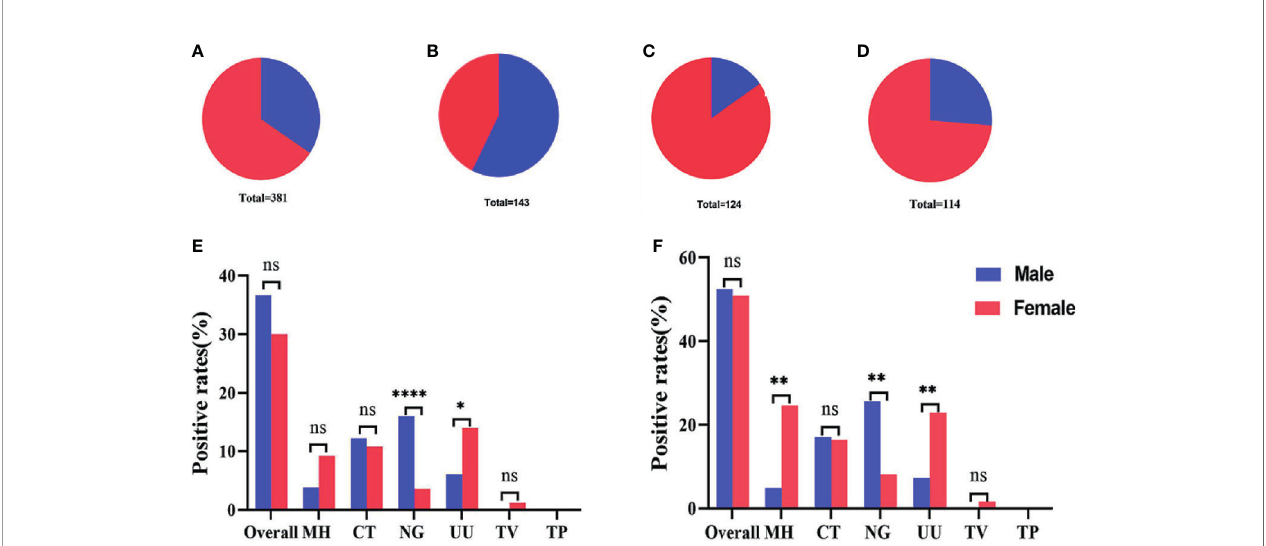
FIGURE 6 | Gender ratio and infection rates across different groups. (A – D) Gender ratio across all 381 subjects, 143 patients with genital tract infections, 124 infertile patients, and 115 healthy controls. (E) The infection rates of 131 males compared with 250 females. (F) The infection rates of 82 males compared with 61 females in the group featuring 143 genital tract infections. *p < 0.05, **p < 0.01, ****p < 0.0001, ns, not signi fi cant; p >